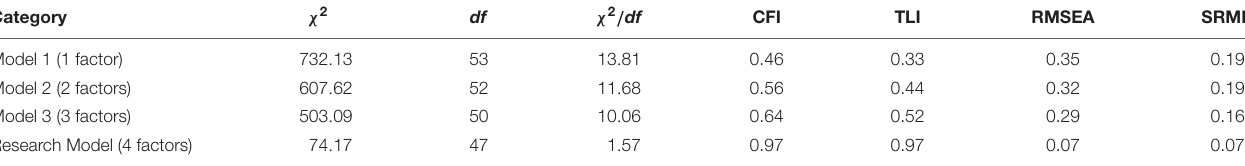
TABLE 2 | Confirmatory factor analysis results.